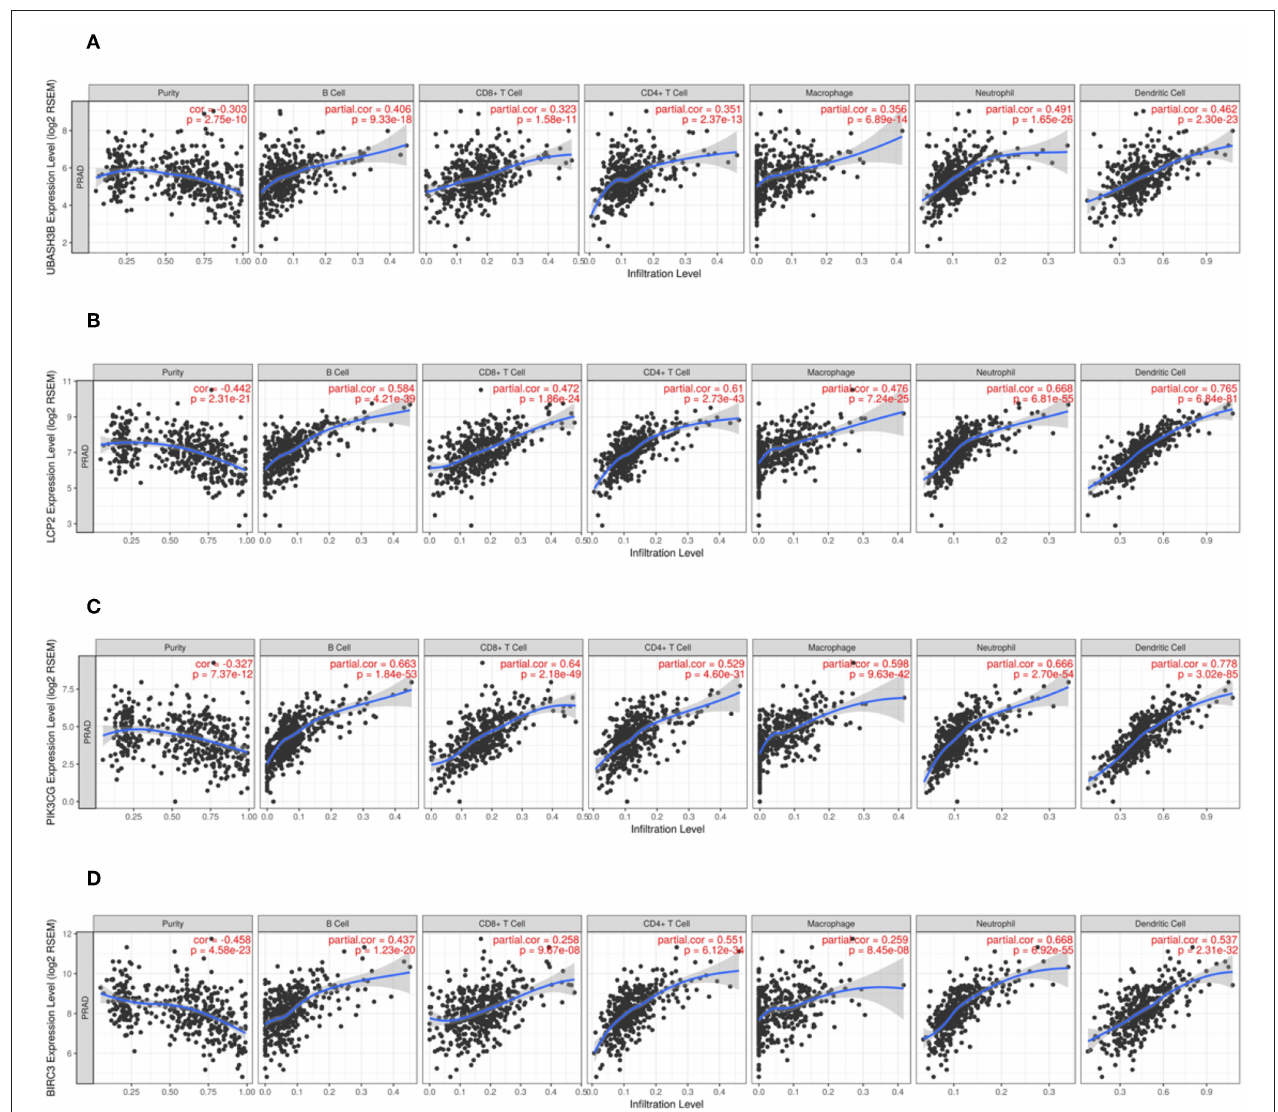
FIGURE 6 | (A) There is a significant correlation between UBASH3B expression and immune cells, including CD4 + T cells, CD8 + T cells, B cells, macrophages, Neutrophils, and dendritic cells. (B) There is a significant correlation between LCP2 expression and immune cells, including CD4 + T cells, CD8 + T cells, B cells, macrophages, Neutrophils, and dendritic cells. (C) There is a significant correlation between PIK3CG expression and immune cells, including CD4 + T cells, CD8 + T cells, B cells, macrophages, Neutrophils, and dendritic cells. (D) There is a significant correlation between BIRC3 expression and immune cells, including CD4 + T cells, CD8 + T cells, B cells, macrophages, Neutrophils, and dendritic